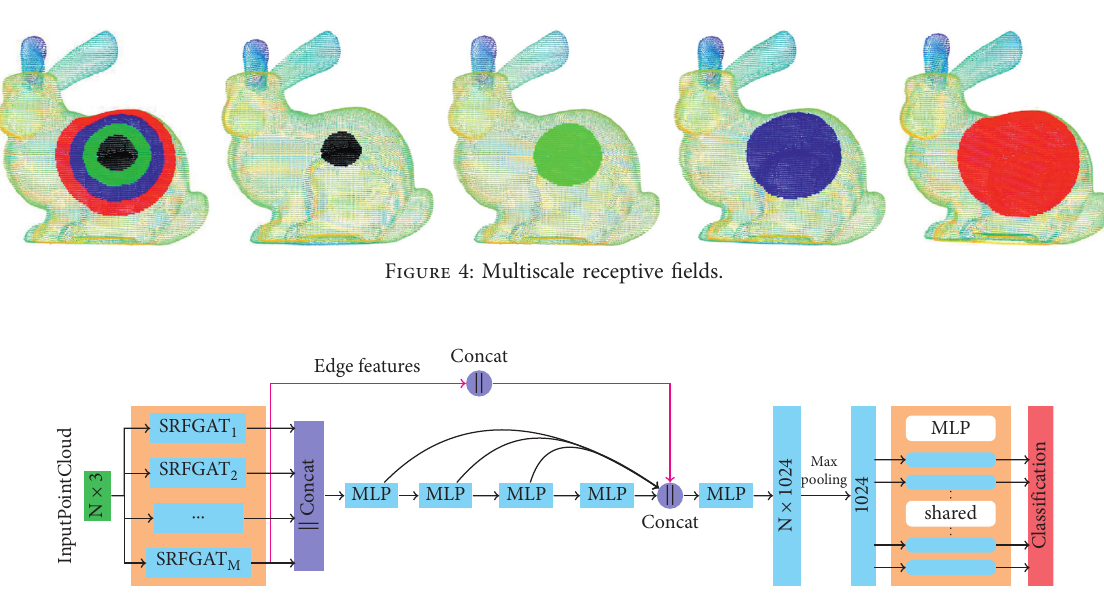
Figure 5: The architecture of classification. In this framework, it takes N points as input and applies M individual SRFGAT modules to obtain multiattention features on multilocal graphs; then, the output features are recast by means of five shared MLP layers and attention pooling layer, respectively. Finally, a shared full-connected layer is employed to form a global feature and then classification scores for c categories are obtained.